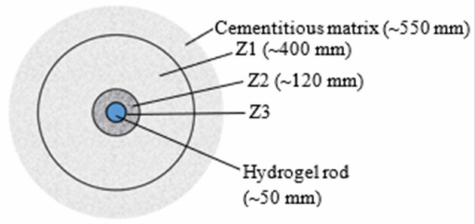
Figure 2. Schematic showing the hydrogel rod and three different zones, Z1, Z2, and Z3, in the cross-section of the cement paste